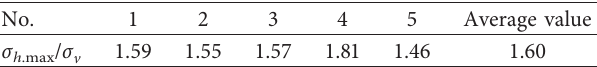
Table 8: Ratio of the maximum horizontal principal stress to vertical principal stress.